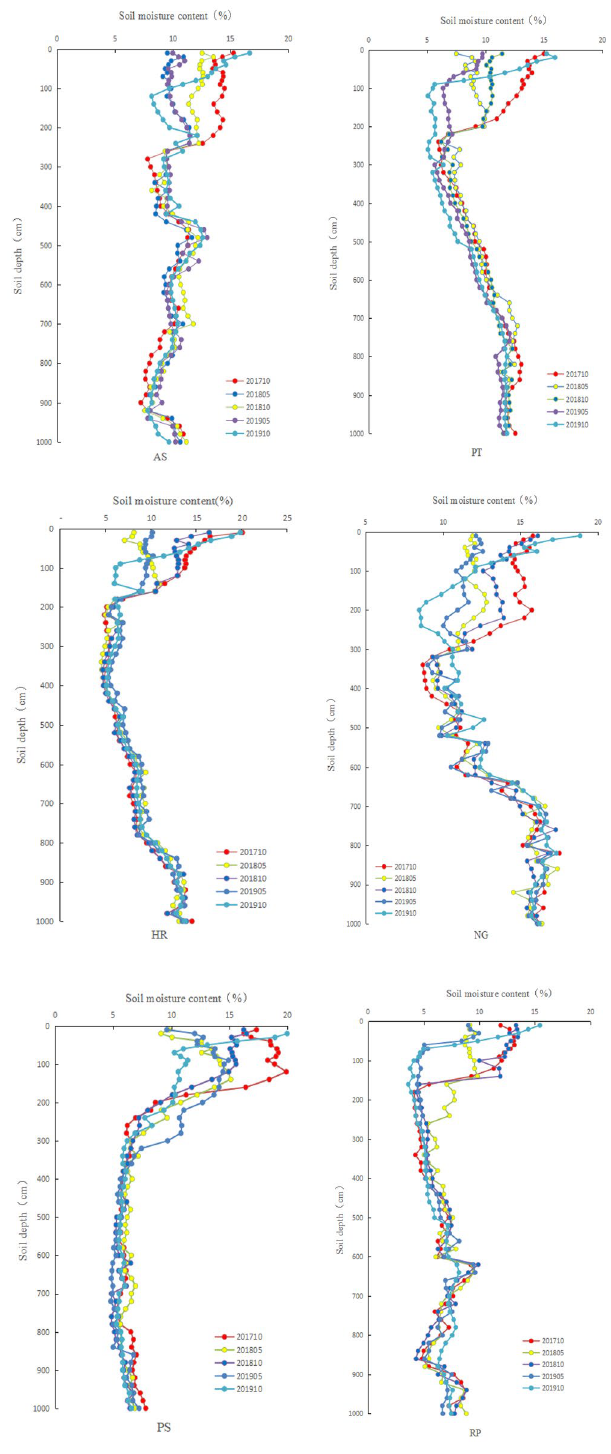
Figure 2. Distribution of the soil moisture in different types of vegetation at 0–10